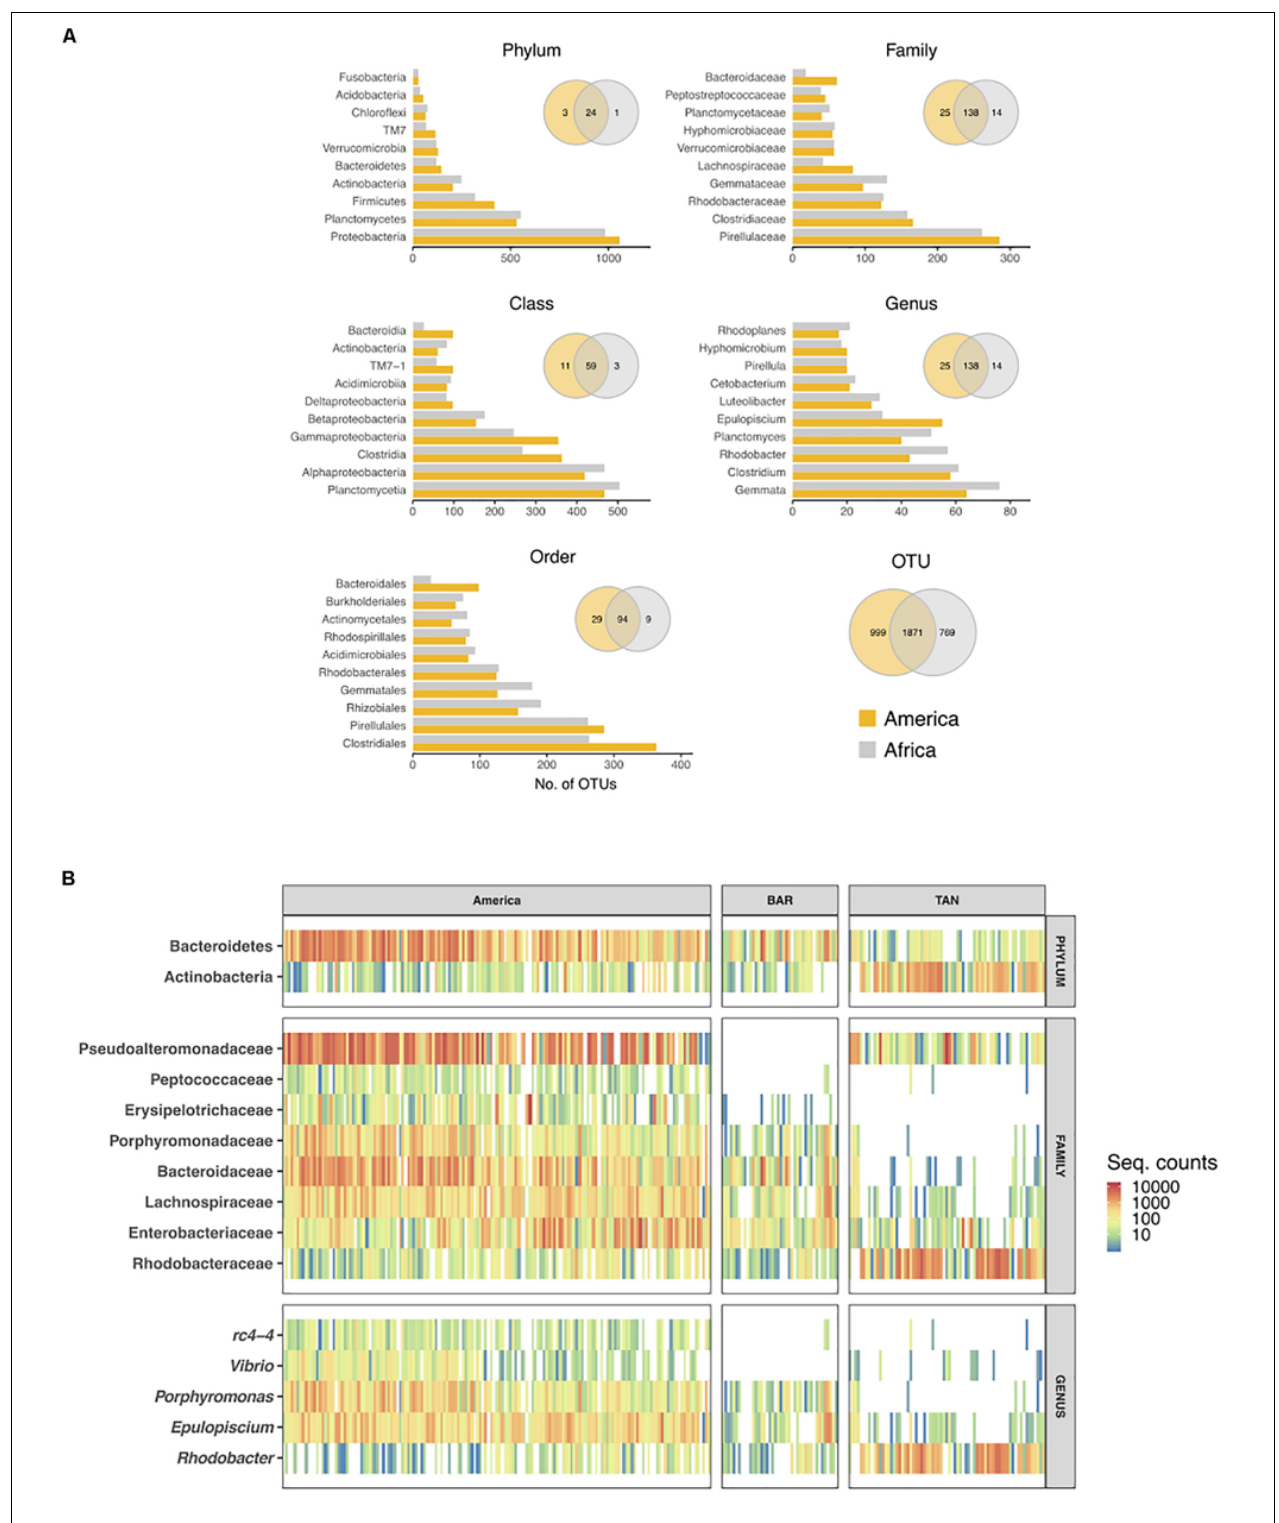
FIGURE 4 | Number of OTUs per bacterial taxon found in each continent (A) and heatmap of differentially abundant taxa between continents (ind. value ≥ 0.70, p ≤ 0.010) (B) . (A) Total number of OTUs per taxon were calculated for each taxonomic rank. Only the 10 richest taxa are shown. Venn diagrams show unique and shared taxa/OTUs between continents. (B) Colors represent taxon abundance (i.e., sequence counts) per specimen (bar), with white indicating zero counts. For comparative purpose, African specimens were ordered and separated by lake. BAR: Barombi Mbo; TAN: Tanganyika. The indicator analyses are based on the rarefied dataset after additional sequence filtering (see section “Materials and